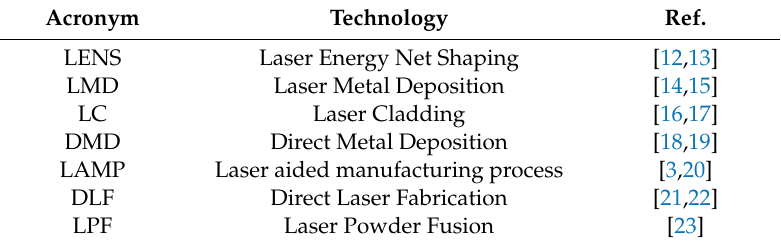
Table 1. Di ff erent commercialized names of the directed energy deposition (DED)